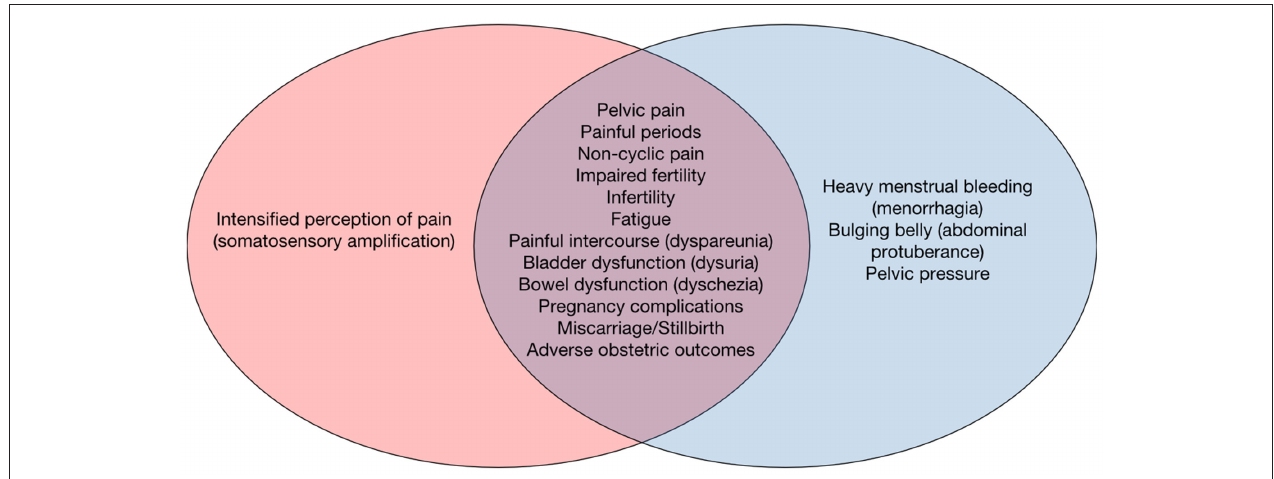
FIGURE 1 | The symptoms of uterine conditions, endometriosis and uterine fibroids overlap. The non-specificity of abdominal and uterine symptoms makes it challenging to differentially diagnose endometriosis (left, red) and uterine fibroids (blue, right) without imaging or even surgical